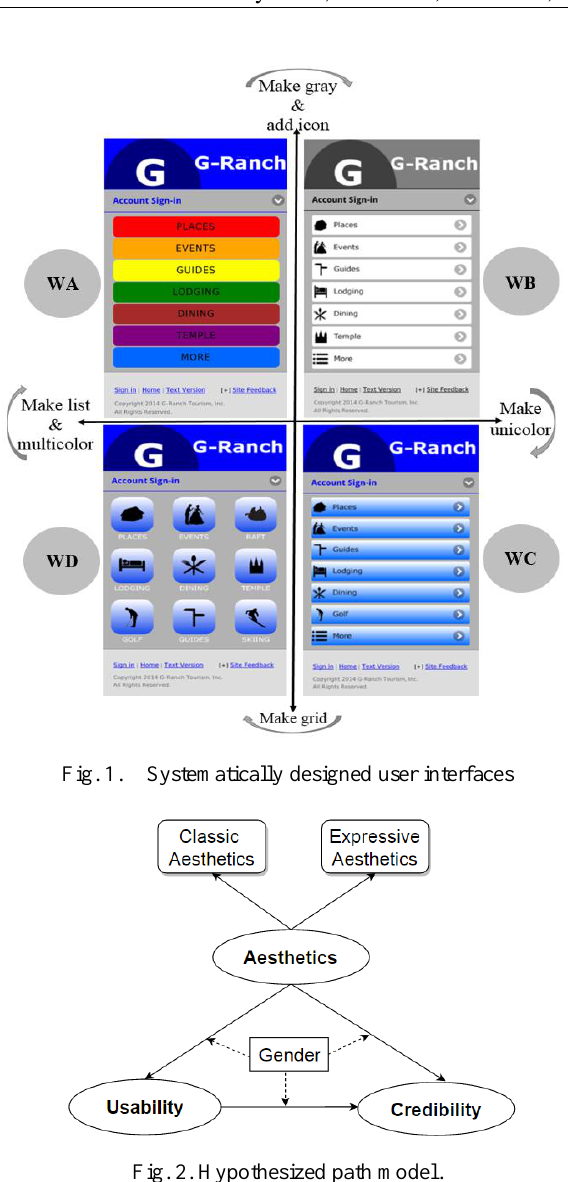
Fig. 2. Hypothesized path